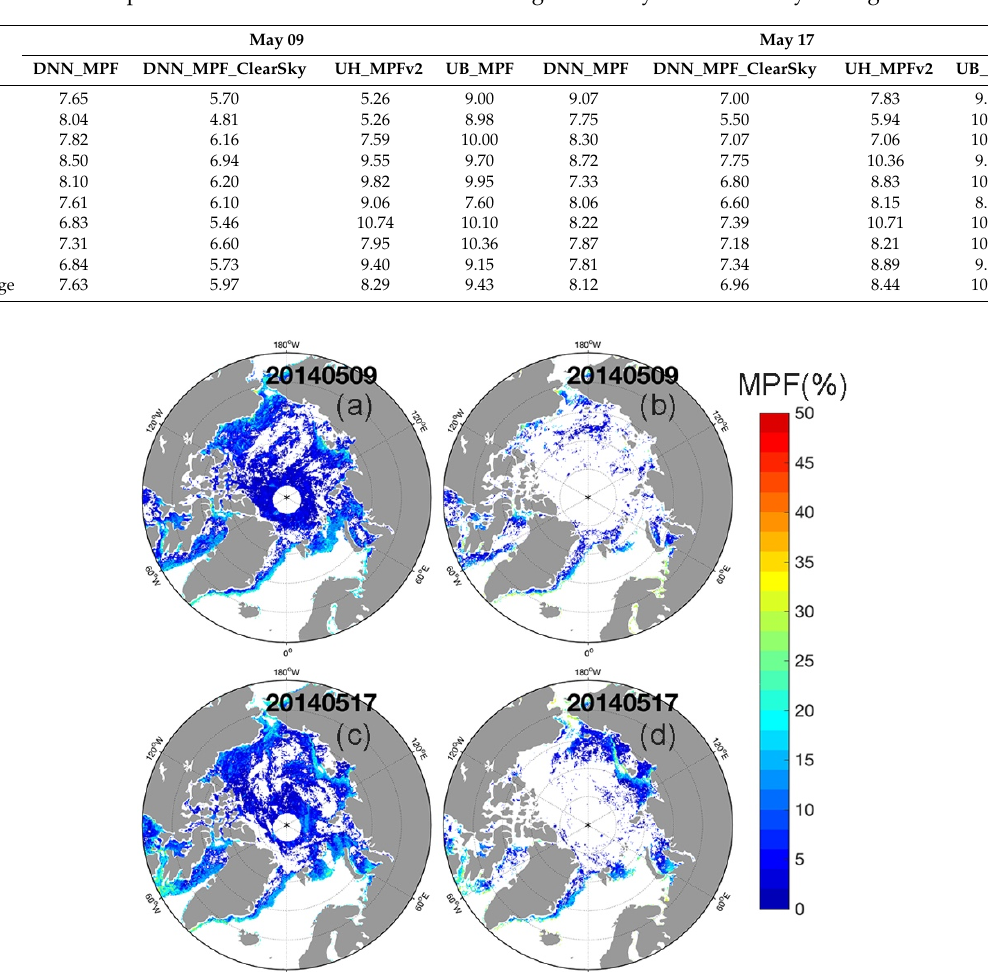
Figure 19. Spatial distribution of the MPF in the first two 8-day periods of 2014. ( a , c ) DNN_MPF. ( b , d ) DNN_MPF_ClearSky.